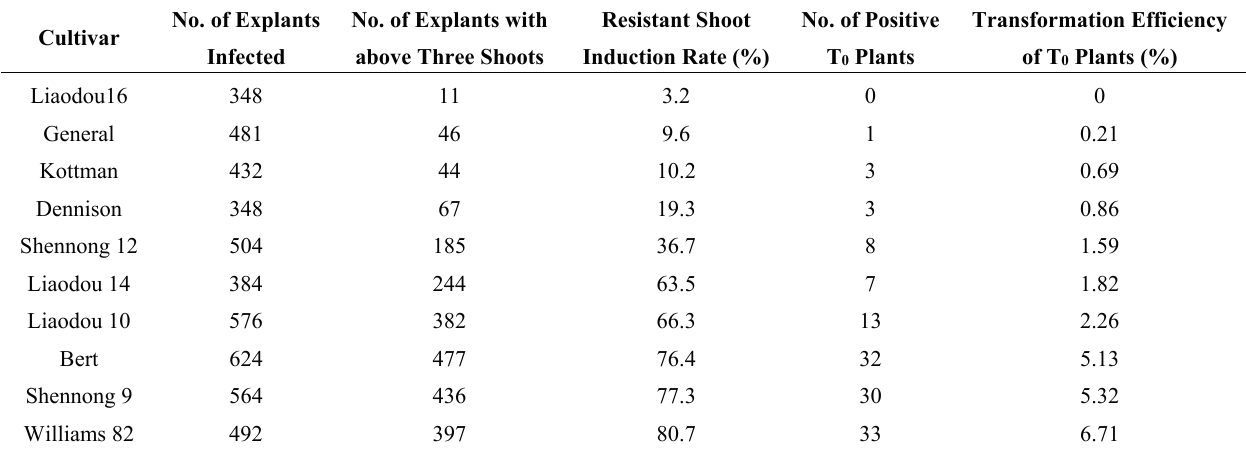
Table 1. Evaluation of 10 soybean cultivars for Agrobacterium -mediated